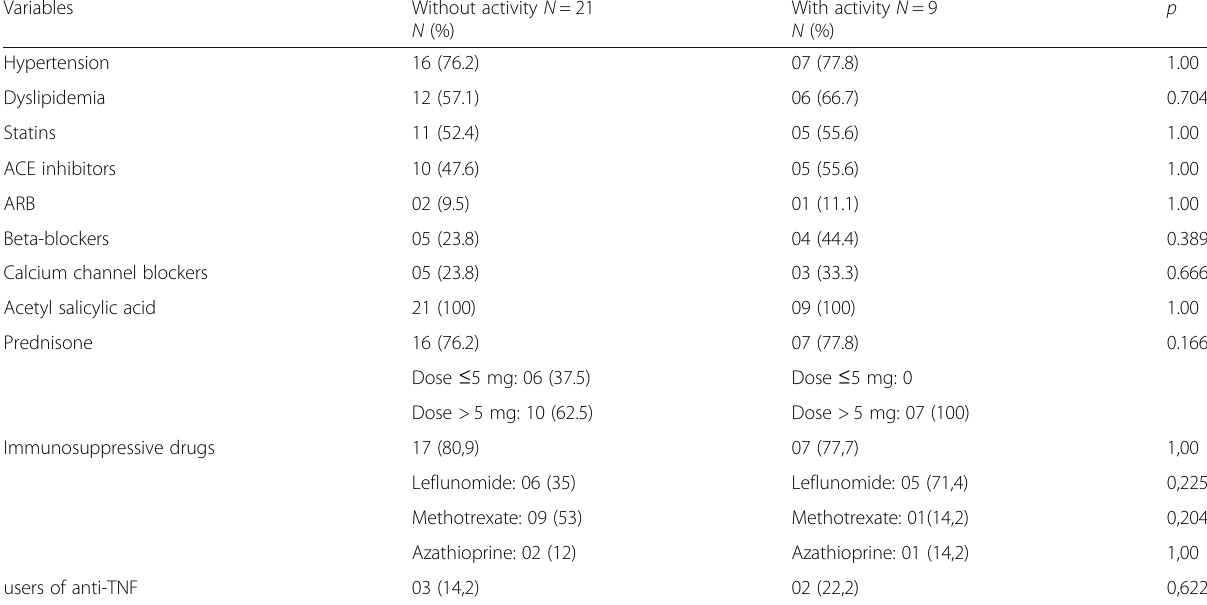
Table 2 Frequency of hypertension, dyslipidemia, and use of medication in patients with and without Takayasu ’ s arteritis activity Variables